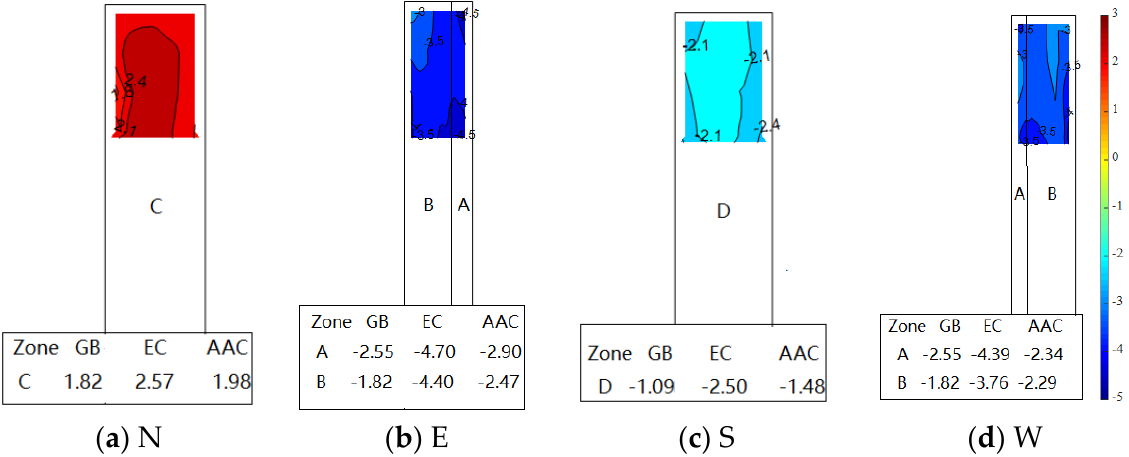
Figure 9. Contour of extreme pressure coefficient at 0 ° wind direction angle: ( a ) N, ( b ) E, ( c ) S, ( d ) W.